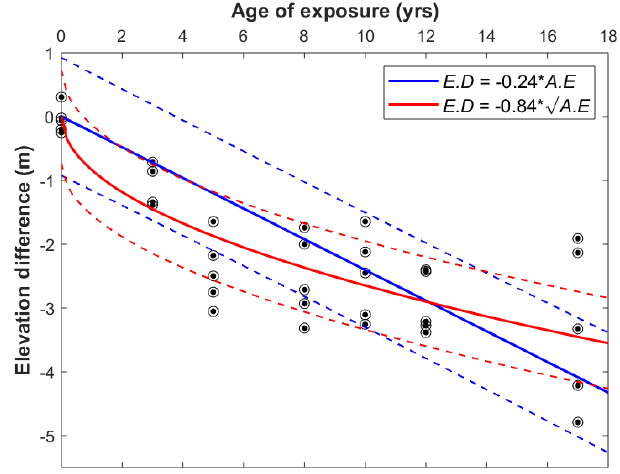
Figure 8. Plot of lakebed subsidence against time since exposure. The elevation difference is modelled as varying linearly (thick blue line, R 2 = 0 . 51) and non-linearly (thick red line, R 2 = 0 . 71) with the age of exposure of the lakebed. Dashed blue and red lines repre- sent the 95% confidence limits. Black bullseyes represent the mea- sured elevation difference between the reconstructed bathymetric DSM and the 2016 topographic DSM at the intersection points of the several profiles taken parallel with the direction of shoreline re- treat as they transect the 2017, 2014, 2012, 2009, 2007, 2005 and 2000 shorelines. Age of exposure is with respect to